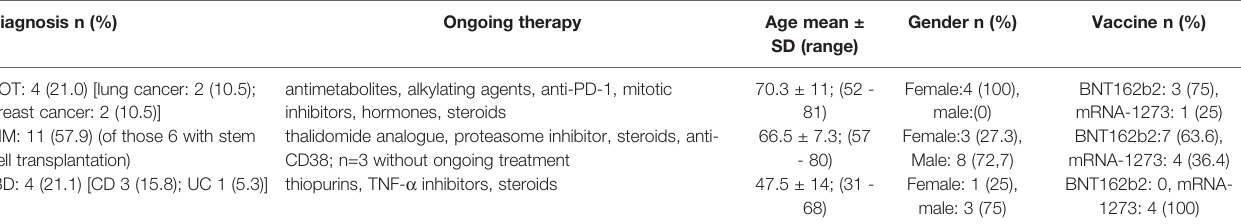
antimetabolites, alkylating agents, anti-PD-1, mitotic inhibitors, hormones, steroids thalidomide analogue, proteasome inhibitor, steroids, anti- CD38; n=3 without ongoing treatment